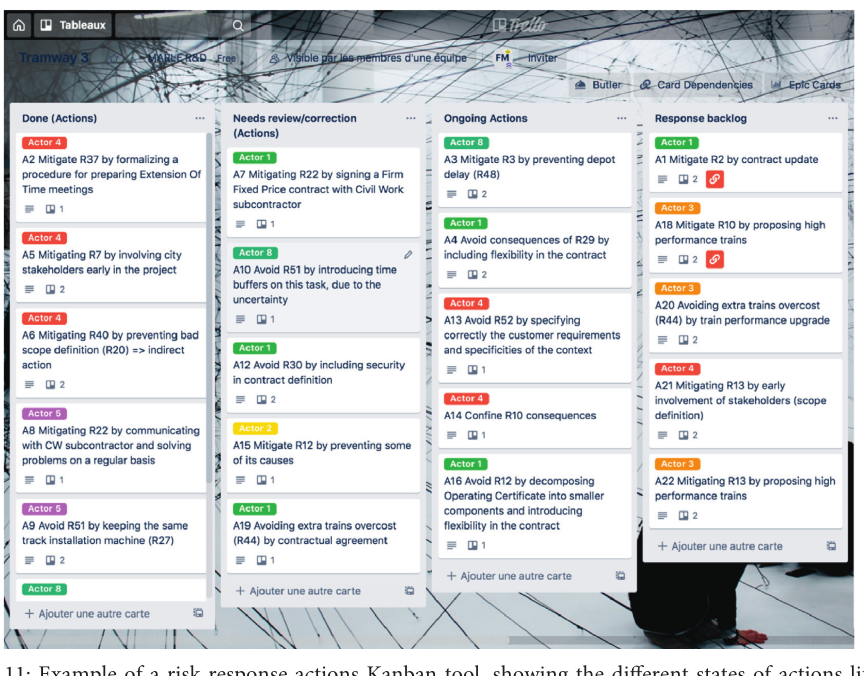
Figure 11: Example of a risk response actions Kanban tool, showing the different states of actions lifecycle.